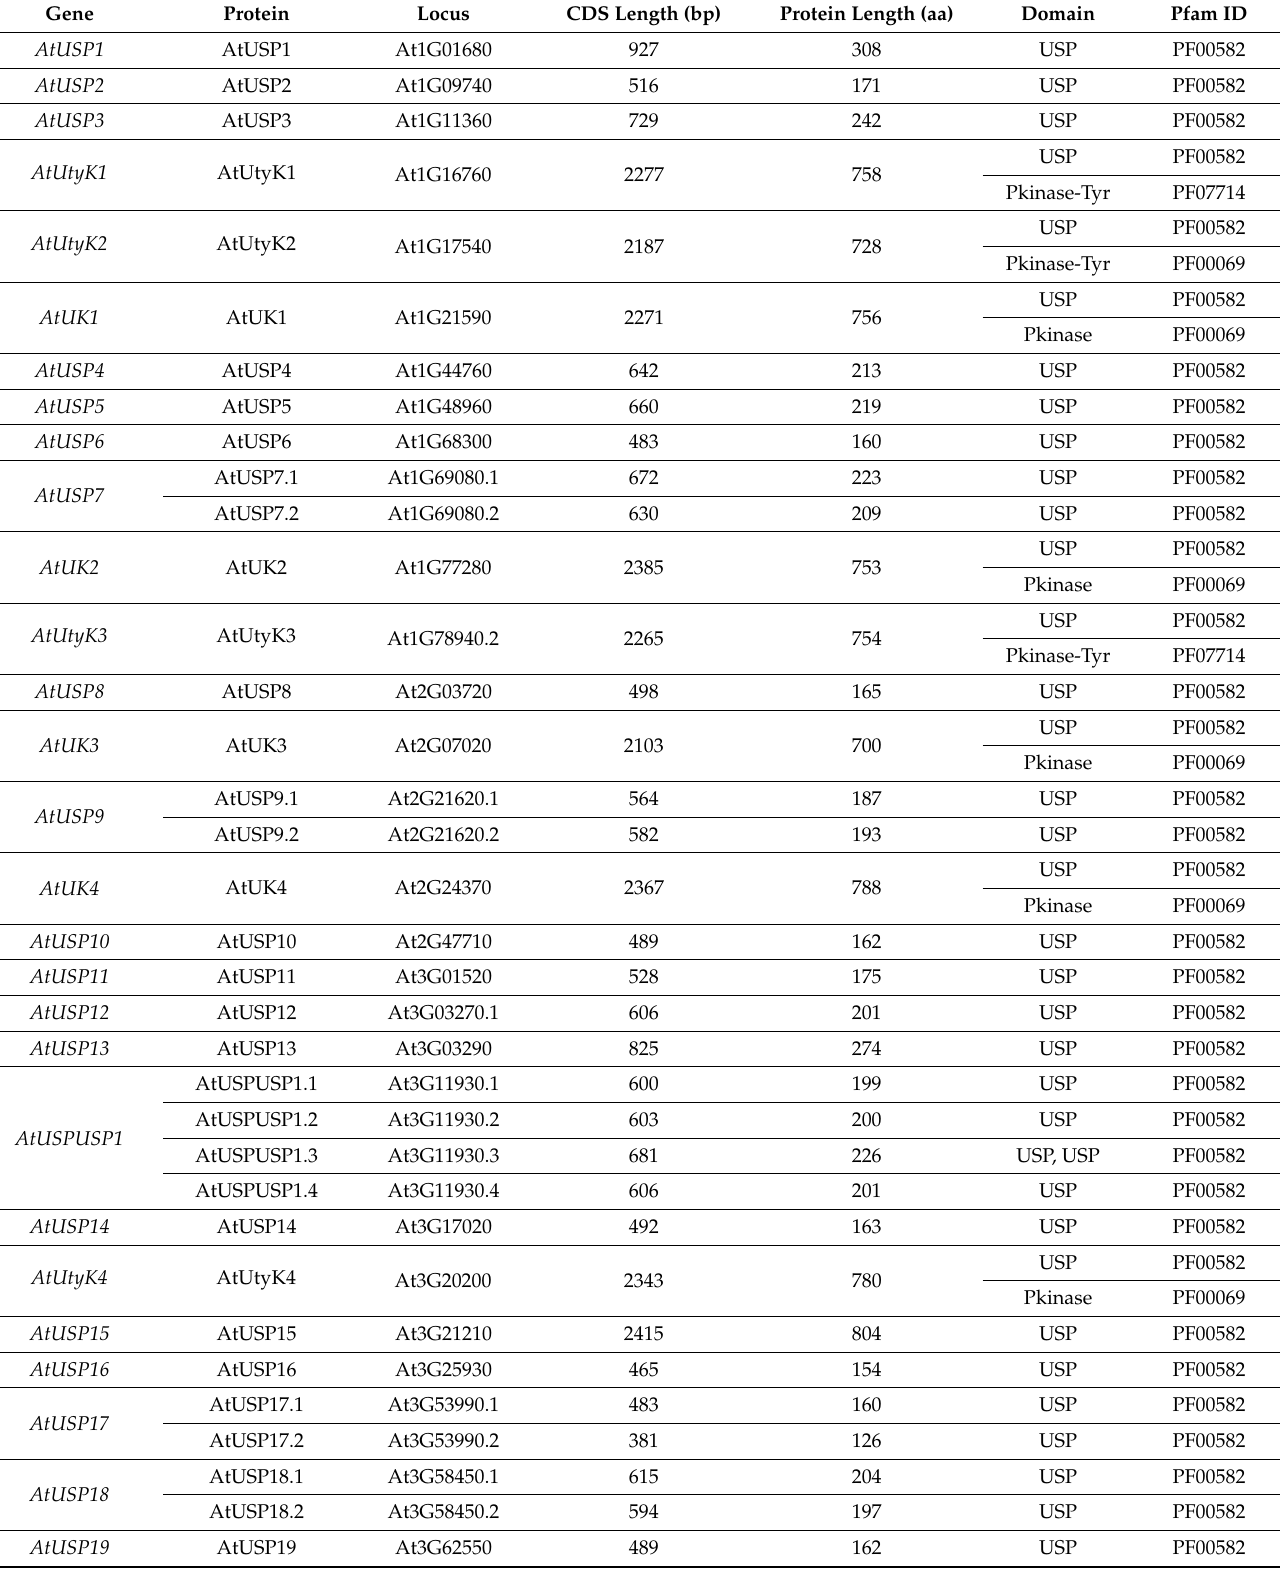
Table 1. List of AtUSP genes in Arabidopsis thaliana along with their corresponding proteins, locus ID, CDS length, protein length, domain and Pfam ID. (Adapted with permission from Ref. [35]. 2023, copyright Springer Nature. and NCBI: https://www.ncbi.nlm.nih.gov/genome/ (accessed on 29 January